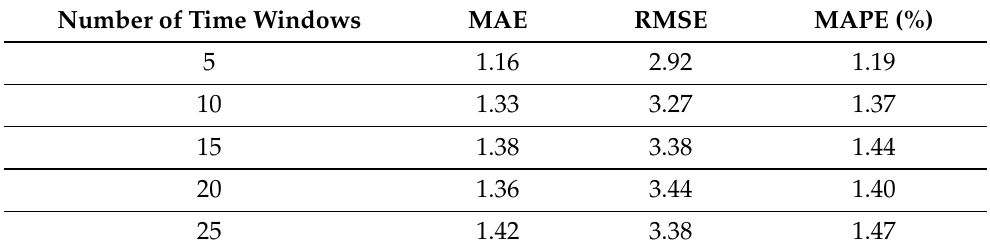
Table 8. The effect of the number of time windows on LSTM models.